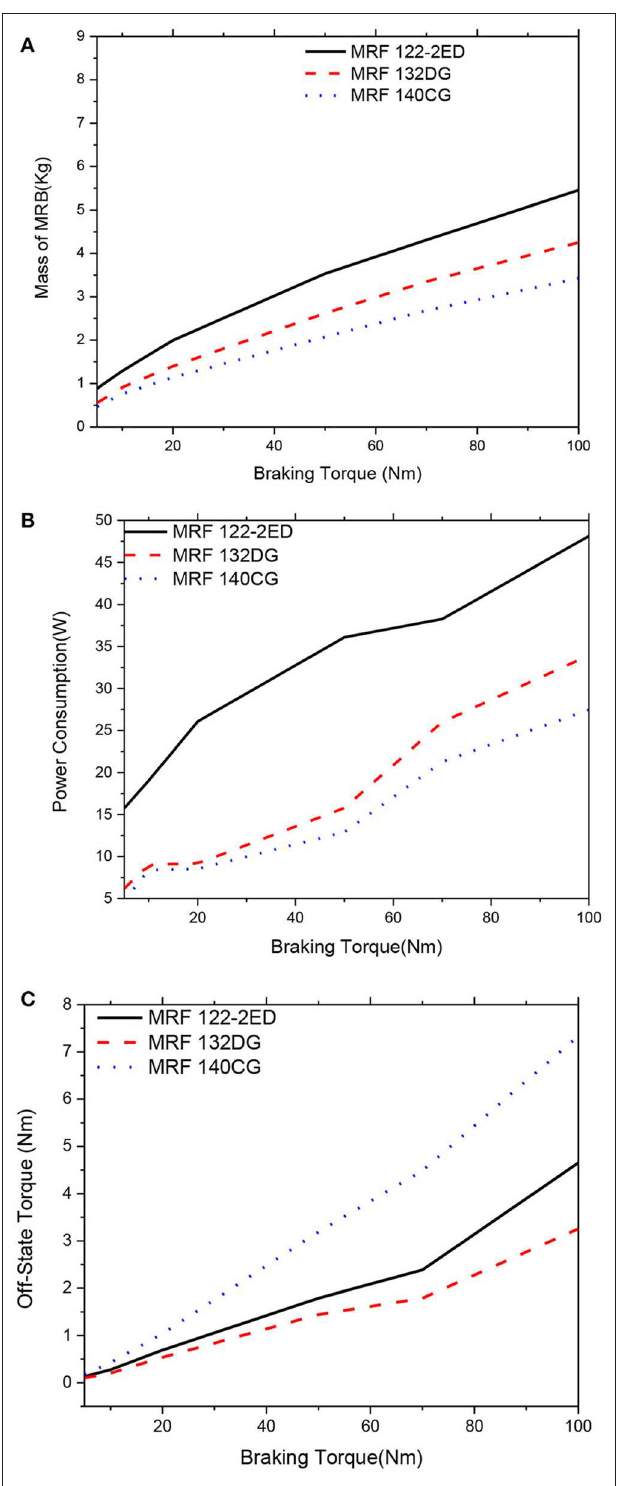
FIGURE 6 | Mass optimization results of the MRBs as a function of braking torque of conventional MRB, d = 0.6mm. (A) Mass as a function of braking torque, (B) Power consumption as a function of braking torque, (C) Off-state torque as a function of braking torque.